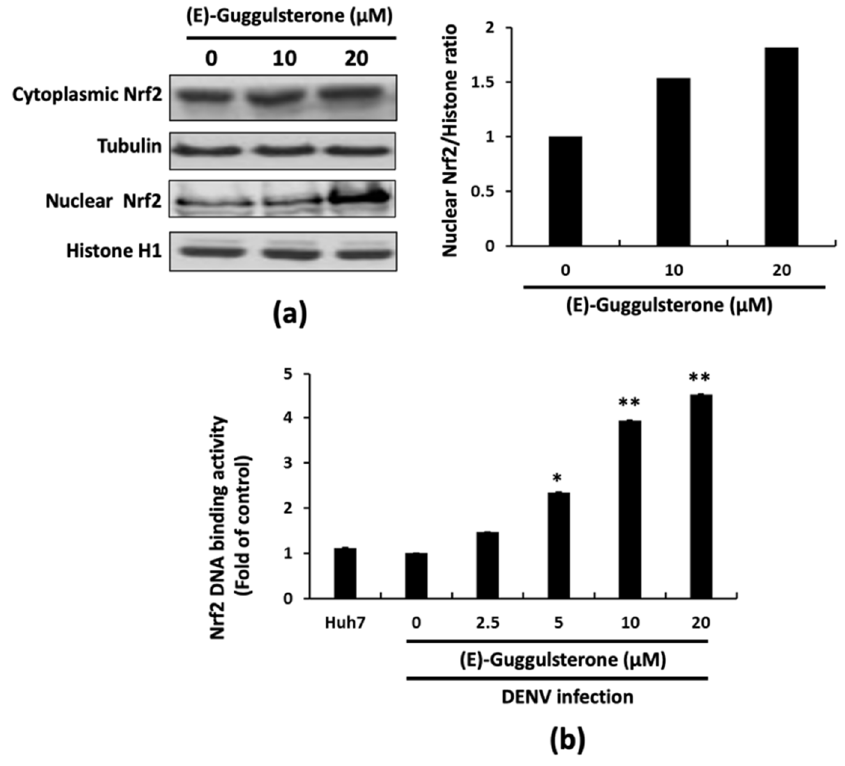
Figure 3. (E)-Guggulsterone upregulates Nrf2 for HO-1 expression. (E)-Guggulsterone enhances cytoplasmic Nrf2 expression and Nrf2 nuclear translocation. ( a ) DENV-infected cells were treated with two different concentrations of (E)-guggulsterone (10 and 20 µ M). The cytoplasmic and nuclear lysates were extracted separately, and Western blotting was performed using anti-Nrf2, anti-Tubulin, and anti-Histone H1 antibodies. Protein concentrations were quantified using densitometric analysis. ( b ) The (E)-guggulsterone stimulated ARE transactivation in a concentration-dependent manner. Huh-7 cells were transfected with the reporter plasmid p3xARE-Luc and infected with DENV for 2 h, followed by treatment with the indicated concentration of (E)-guggulsterone for 3 days. The relative induction of promoter activity was determined using a luciferase assay. The results are presented as fold activation compared to the DENV-infected cells, with 0.1% DMSO treatment defined as “0”. The error bars for treatment denote the mean ± SD of three independent experiments ( n = 3). * p < 0.05; ** p < 0.01.